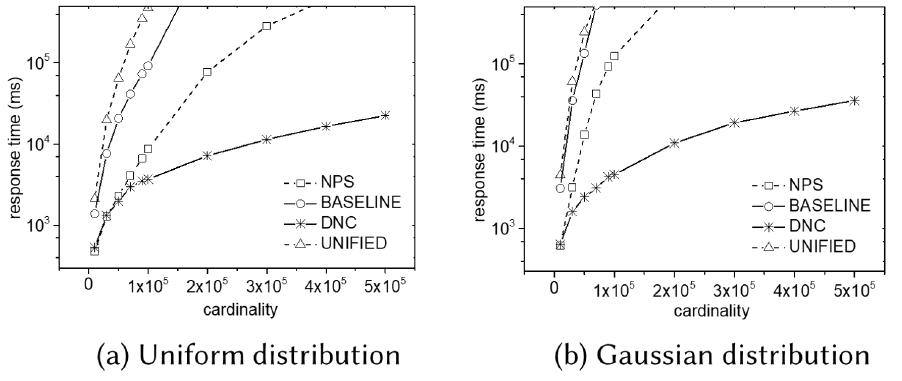
Figure 11. Effect of data size in 3D